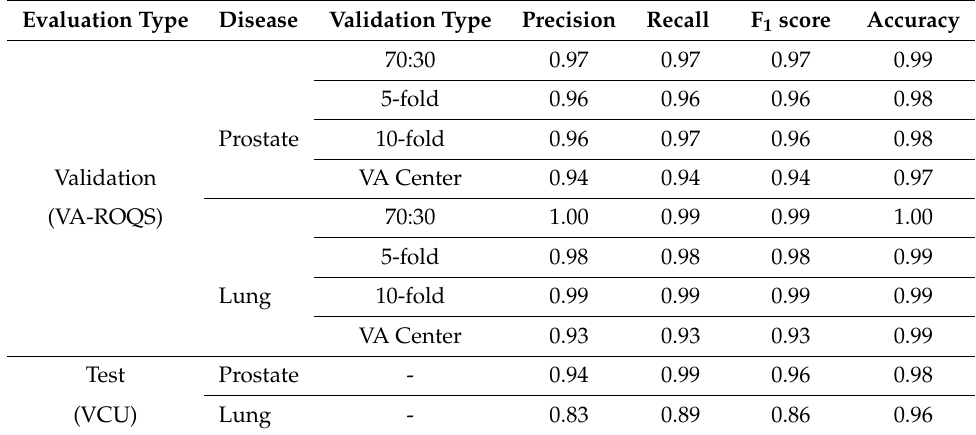
Table 5. Disease specific macro-averaged precision, recall, F 1 score, and overall accuracy for validation and test